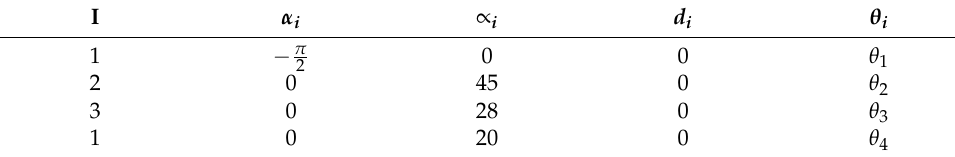
Table 1. DH parameters of the